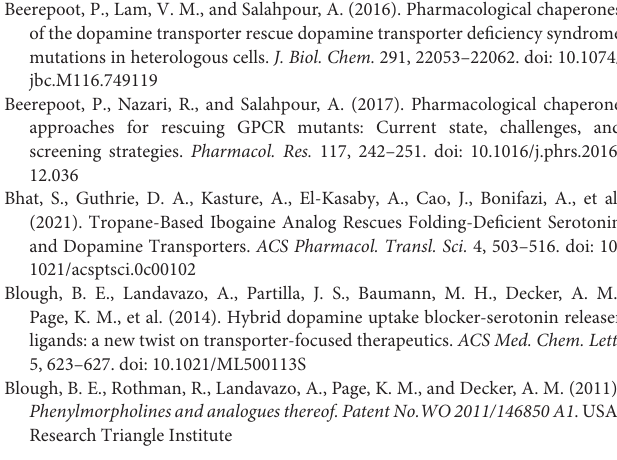
meta position on chaperone efficacy. (C) Impact of addition of a second Cl on chaperone efficacy. Supplementary Figure 5 | Broader study of the impact of phenyl substitutions on the efficacy of bupropion in the WT DAT blac assay. (A) Impact of 3-phenyl substitutions on chaperone efficacy of compounds with an N-tertbutyl group. (B) Impact of 3-phenyl substitutions on chaperone efficacy of compounds with an N-cyclobutyl group. (C) Impact of 3-phenyl substitutions on chaperone efficacy of compounds with an N-cyclopropyl group. Supplementary Figure 6 | Impact of N-alkylation on the efficacy of bupropion in the WT DAT blac assay. (A) Impact of tertiary amines on chaperone efficacy. (B) Impact of smaller alkyl groups on chaperone efficacy. (C) Impact of iso-alkyl groups on chaperone efficacy. Supplementary Figure 7 | Effect of the alkyl chain length and ketone substituent on the efficacy of bupropion in the WT DAT blac assay. (A) Impact of alkyl chain length on chaperone efficacy. (B) Impact of the addition of a methylene group on chaperone efficacy. (C) Impact of the addition of a ketone on chaperone efficacy. Supplementary Figure 8 | Efficacy of 6-hydroxybupropion in the WT DAT blac assay. (A) Impact of the addition of a second halogen on chaperone efficacy of 6-hydroxybupropion. (B) Impact of the removal of hydroxyl and methyl groups from 6-hydroxybupropion on chaperone efficacy. Supplementary Figure 9 | Demonstration of bupropion converted to its metabolite 6-hydroxybupropion. Supplementary Figure 10 | Bicifadine and RTI-5 are potential bupropion analogues to be explored further for SAR analysis. (A) Bupropion and bicifadine have similar chaperone efficacy. (B) Bupropion and RTI-5 have similar chaperone efficacy. Supplementary Figure 11 | Effect of the hydroxyl substitution on the efficacy of ibogaine in the WT DAT β lac assay. Supplementary Figure 12 | Effect of the isoquinuclidine substituent and ring size on the efficacy of ibogaine in the WT DAT blac assay. (A) Impact of the removal of the isoquinuclidine substituent in addition to various phenyl substitutions on chaperone efficacy. (B) Impact of ring size on chaperone efficacy. Supplementary Figure 13 | Effect of the tryptamines on the efficacy of tryptamine analogs in the WT DAT β lac assay. Supplementary Figure 14 | Key structural features of bupropion and ibogaine for pharmacological chaperone efficaciousness. (A) Bupropion’s key structural features for pharmacological chaperone activity include the halogen derivation at the meta position (pink) and the secondary amine (green). (B) Ibogaine’s key structural features for pharmacological chaperone activity include hydroxyl substitution (blue) and the presence of the isoquinuclidine group